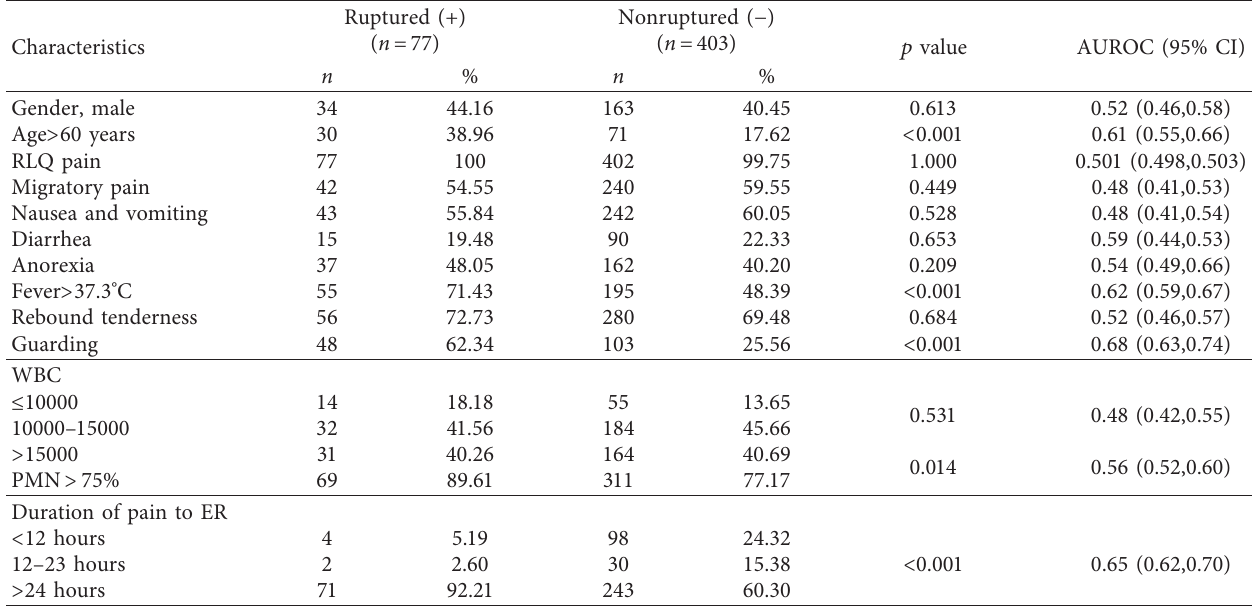
Table 1: Clinical characteristics of participants categorized by pathology results as ruptured or nonruptured appendicitis. Characteristics